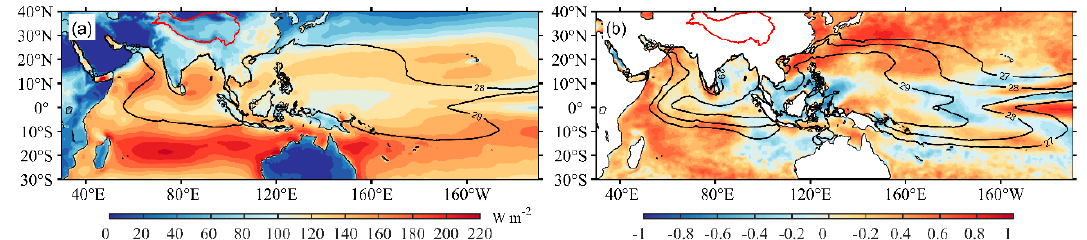
Figure 7. ( a ) Spatial pattern of summer mean surface latent heat flux ( slhf ) (unit: W m − 2 ), and ( b ) its correlation with sea surface temperature (SST) in the IPWP from 1979 to 2018. The red solid line is the boundary of the TP, and the black solid lines are isolines at 27/28/29 of the SST.